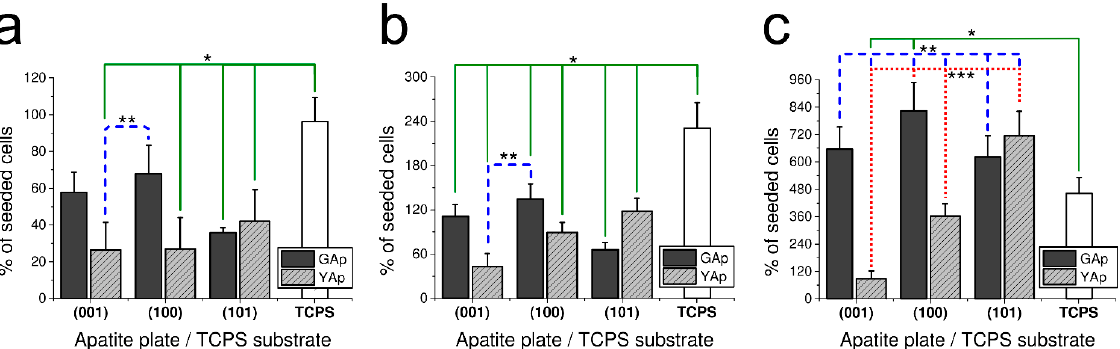
Figure 1. The fibroblast-cell growth-rate (calculated as a percentage of seeded cells) on apatite plates compared with TCPS substrate after 48 h ( a ), 3 days ( b ) and 5 days ( c ) of incubation. The number of cells seeded was 500 cells/mm 2 in the case of ( a ) and 200 cells/mm 2 in the case of ( b , c ). * Significant difference ( p < 0.05) compared with TCPS control (continuous line). ** Significant difference ( p < 0.05) between (001) YAp and remaining apatite plates (dashed line). *** Significant difference ( p < 0.05) between (100) YAp and three other apatite plates: (001), (101) YAp and (100) GAp (dotted line). The bar graphs represent the mean ± SD of three independent experiments.